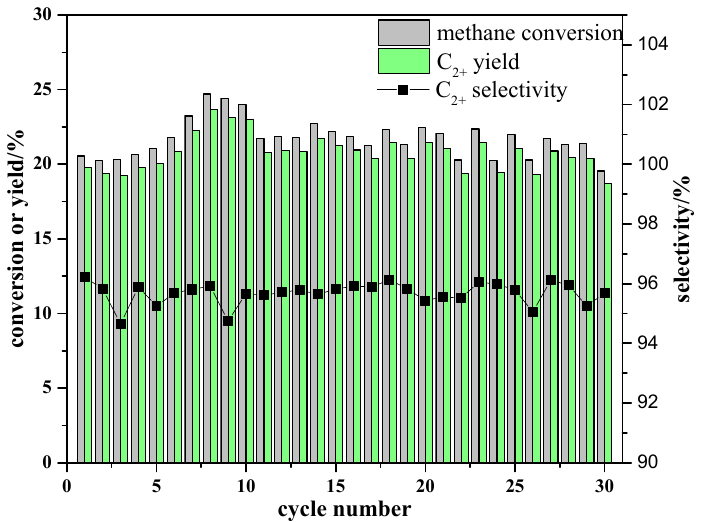
Figure 15. CLOCM of the MnTi catalyst (temperature: ambient temperature, flow rate: 60 mL/min, applied voltage: 100